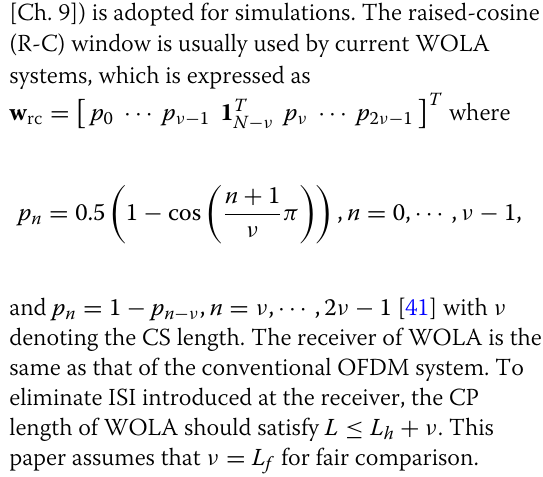
[Ch. 9]) is adopted for simulations. The raised-cosine (R-C) window is usually used by current WOLA systems, which is expressed as w rc =